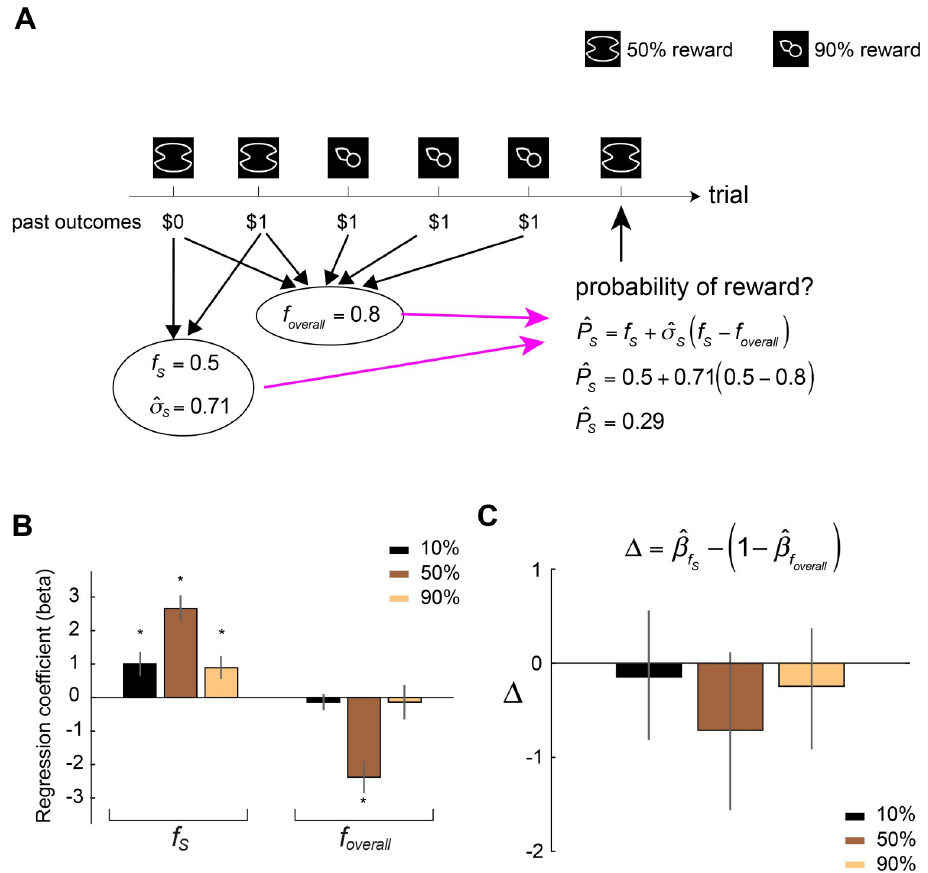
Fig 6. Testing the URD model for context-dependent probability estimation. (A) Illustration of the URD model. (B) Regression analysis. In three separate multiple regression analyses each examining a particular reward probability, we estimated the weight subjects assigned to frequency of reward associated with a stimulus ( f ) and the overall S frequency of reward associated with the context ( f overall ) and plot the mean regression coefficients across all subjects. Error bars represent ± 1 SEM. The star symbol indicates statistical significance (testing the mean regression coefficient against 0 at p < 0.05). (C) We compare ^ b with ð 1 (cid:0) ^ b Þ for each reward probability separately. The vertical axis f S f overall represents Δ , where D ¼ ^ b (cid:0) ð 1 (cid:0) ^ b Þ . We computed Δ for each subject separately and plot the mean Δ across f S f overall subjects. Error bars represent 95% bootstrap confidence interval of the mean Δ . Data underlying these graphs can be found in https://osf.io/48j7m. URD, uncertainty and reference dependent. model. DN computes probability estimate of a stimulus by having its frequency of reward divided by the sum of the frequency of reward associated with the two stimuli in a context or divided by the average reward frequency of a context (Eqs 9 and 10 in “Materials and meth- ods”). RN uses the difference between the maximum and the minimum stimulus reward fre- quency in a context in the denominator to compute probability estimates (Eq 11 in “Materials and methods”). Both model classes predict large context effect on probability estimates at 50% reward and nonsignificant effect at 10%, which are consistent with what we observed in this data set. However, both models also predict large context effect at 90% reward, which we did not observe in subjects’ probability estimates. For example, in the simplest form of divisive normalization without free parameters [32]— ^ P ¼ f = ð f þ f Þ —the normalized value of 10% S S S OS reward in the [10%, 50%] context is 0.1 � (0.1 + 0.5) = 0.167 (suppose that f = 0.1, f = 0.5) s OS and in the [10%, 90%] context is 0.1 � (0.1 + 0.9) = 0.1 (suppose that f = 0.1, f = 0.9). The s OS